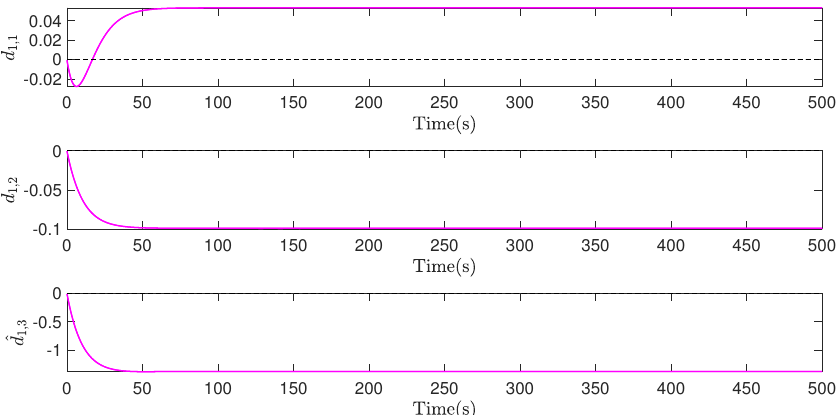
Figure 8. ˆ d 1 , outputs of adaptive law of airship A 1 , in former 500